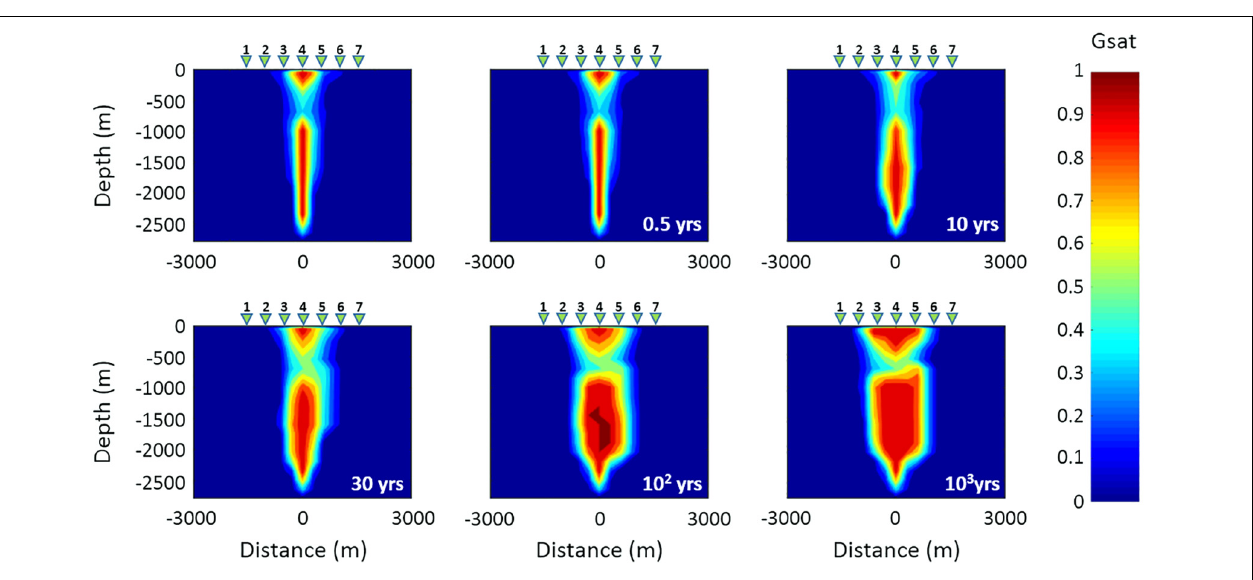
FIGURE 6 | Time evolution of the gas saturation distribution related to Scenario I in the vertical section along the red line shown in Figure 3 . The first panel of the sequence shows the initial gas saturation distribution. The green triangles 1–7 indicate the MT